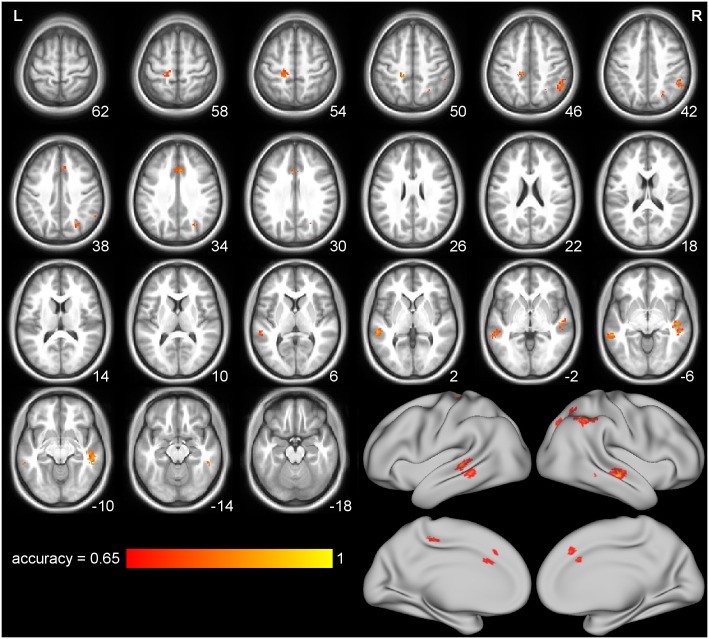
The six clusters in which confederate role could be classified in the searchlight MVPA.Slice numbers are coordinates in mm. These clusters were identified by taking voxels with p < .01 in the permutation test, with a minimum cluster size of 50 voxels; Fig E in S1 Text has a less thresholded (p < .05 uncorrected) image for comparison.